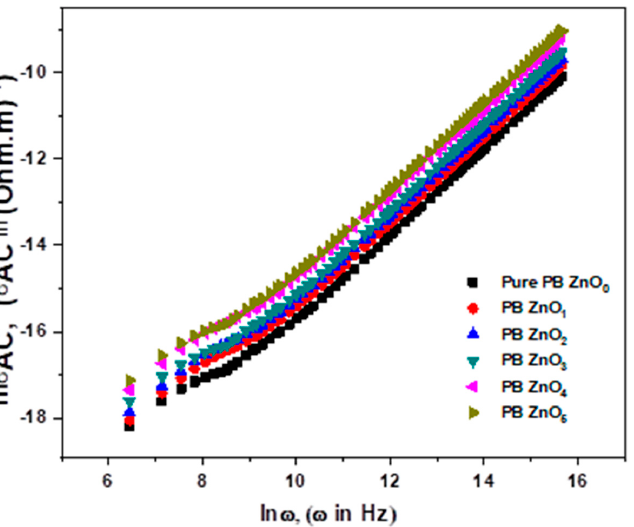
Figure 12. AC conductivity versus angular frequency for different systems with various wt.% of ZnO nanofillers.